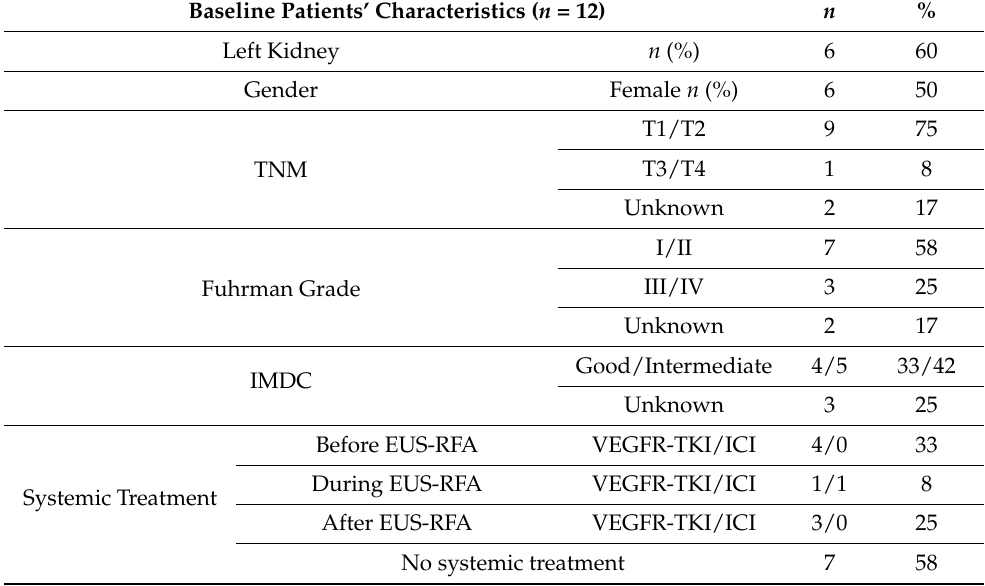
Table 1. Baseline patients’ characteristics ( n =